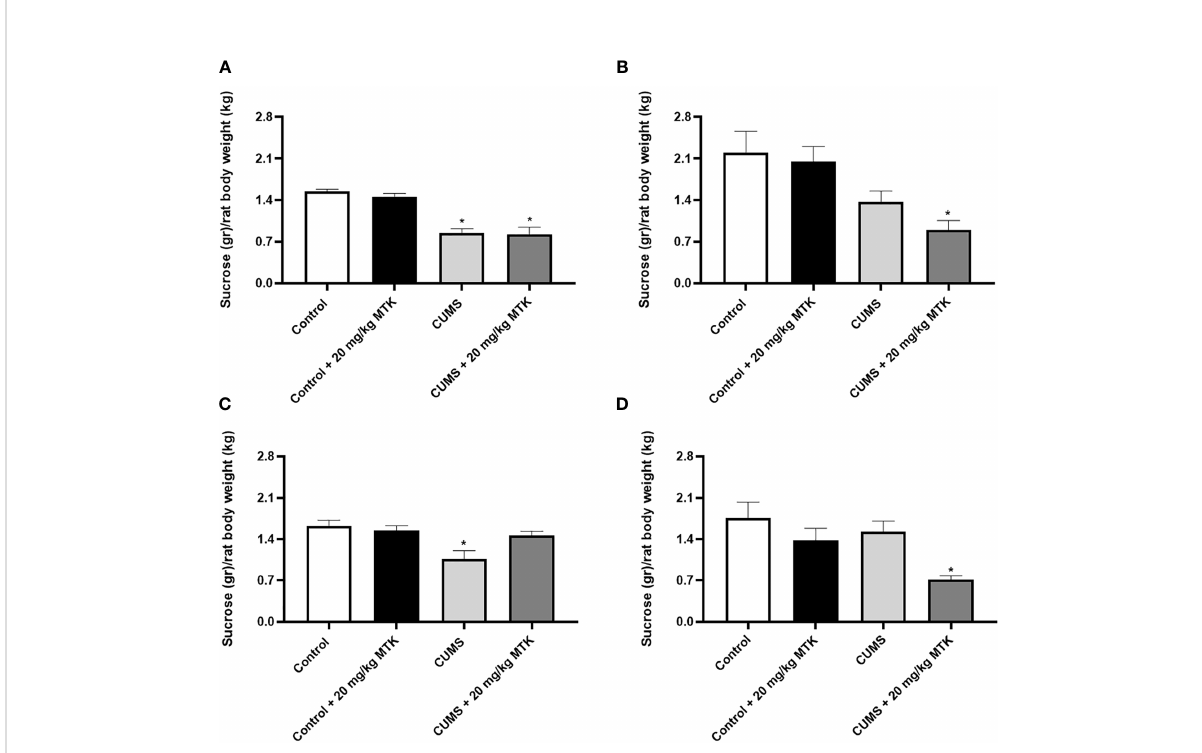
FIGURE 4 Effects of MTK on sucrose consumption. Male (A, C) and female (B, D) rats were exposed to CUMS or control conditions for four weeks (A, B) and then, while remaining under these conditions, were treated for two weeks with MTK 20 mg/kg or vehicle (C, D) . Each column is the mean ± SEM of 12 to 18 rats per group. Using one-way ANOVA (with Benjamini – Hochberg False Discovery Rate), followed by Student ’ s t-test for speci fi c group comparisons: *p < 0.05 vs. Control +